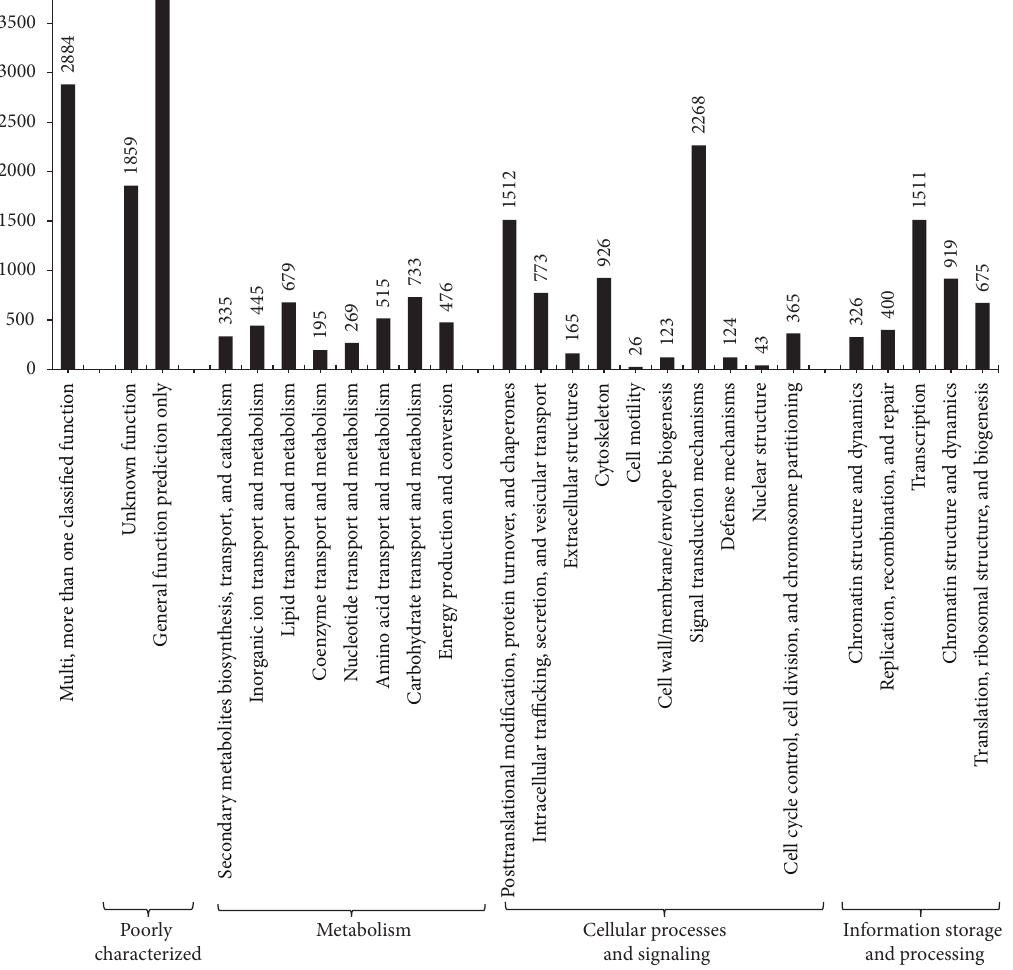
Figure 4: Clusters of Orthologous Groups (KOG DB) based functional analysis of V. mandarinia unigenes. The unigenes on the basis of KOG DB analysis are classified to metabolism, cellular processes and signaling, information storage and processing, and poorly characterized gene